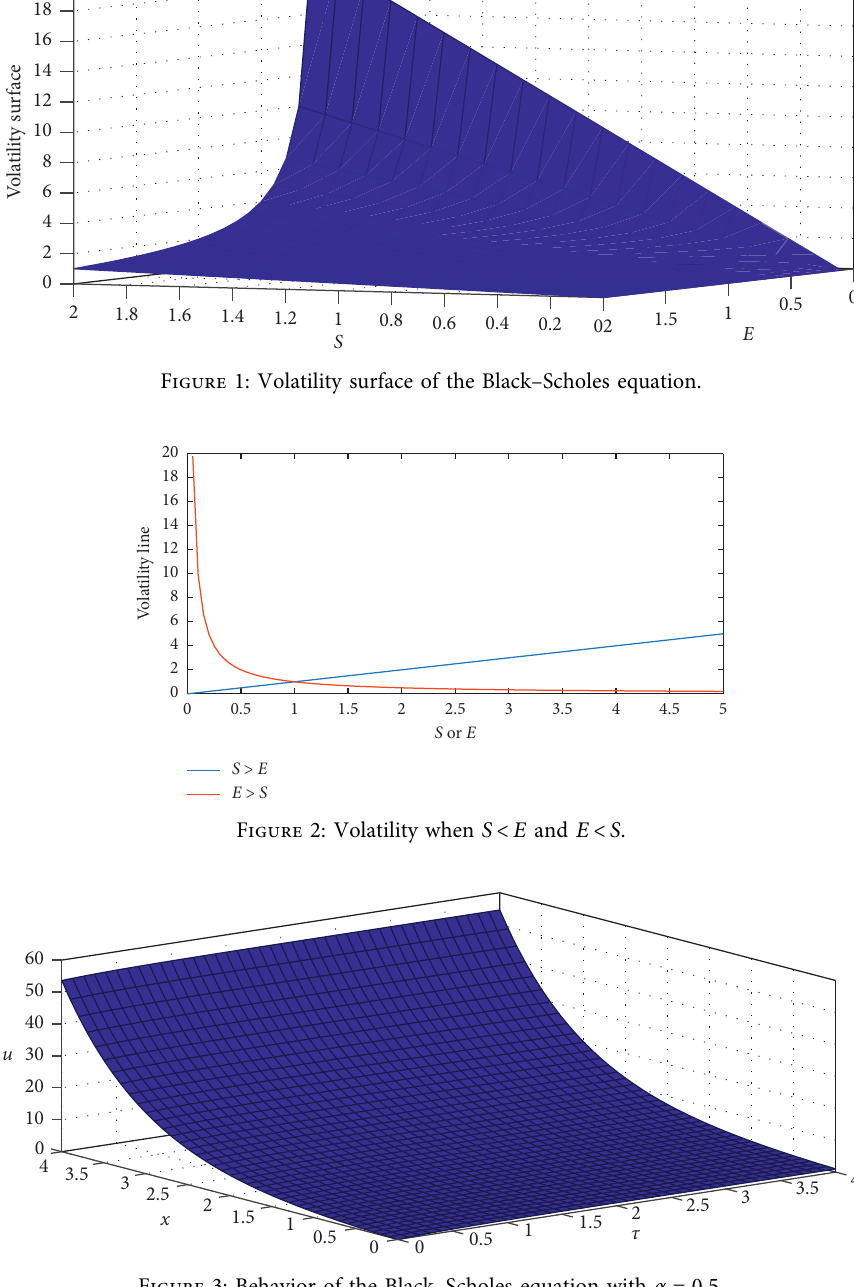
Figure 3: Behavior of the Black–Scholes equation with α � 0 .